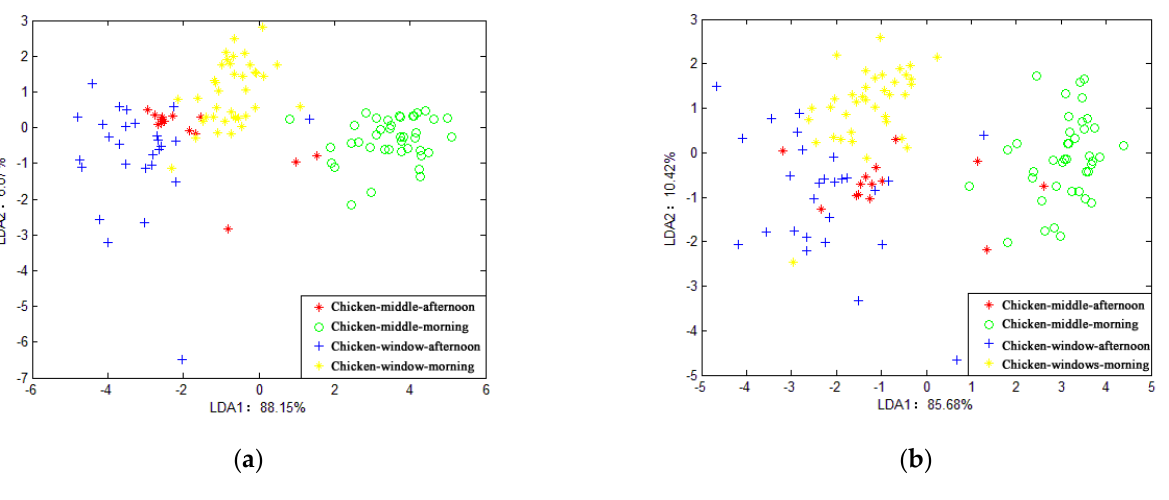
Figure 8. LDA chart of chicken house gas. Table 5. The accuracy for odor classification in different sampling locations of piggery for the same sampling time.